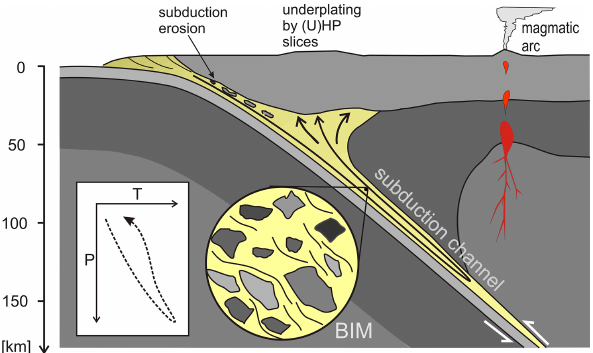
Fig. 1: Envisaged geometry of deep subduction channel (DSC), including subduction erosion and underplating (after Stöckhert, 2002). Insets show scale-invariant block in matrix (BIM) structure and typical pressure–temperature ( P–T ) path derived for rapidly exhumed high P/T metamorphic